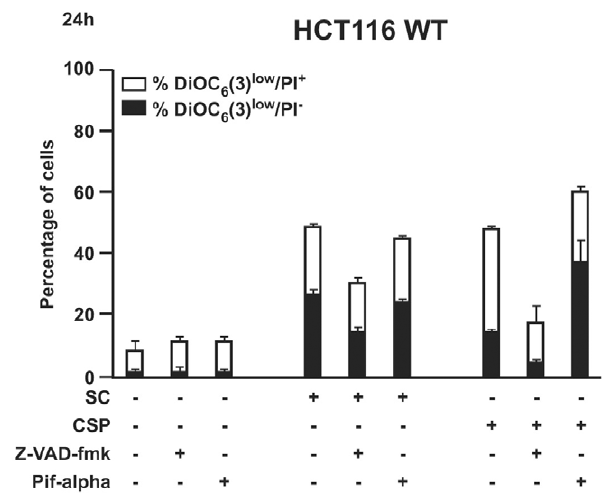
Figure 5. Effect of SC and CSP on cell viability. FACS analysis shows the effect of SC (10 m g/ml) or CSP (10 m g/ml) on HCT116 cell viability in the presence or absence of Z-VAD-fmk (50 m M) and pifthrin- alpha (30 m M). Data are the mean 6 SD of three experiments in triplicate.